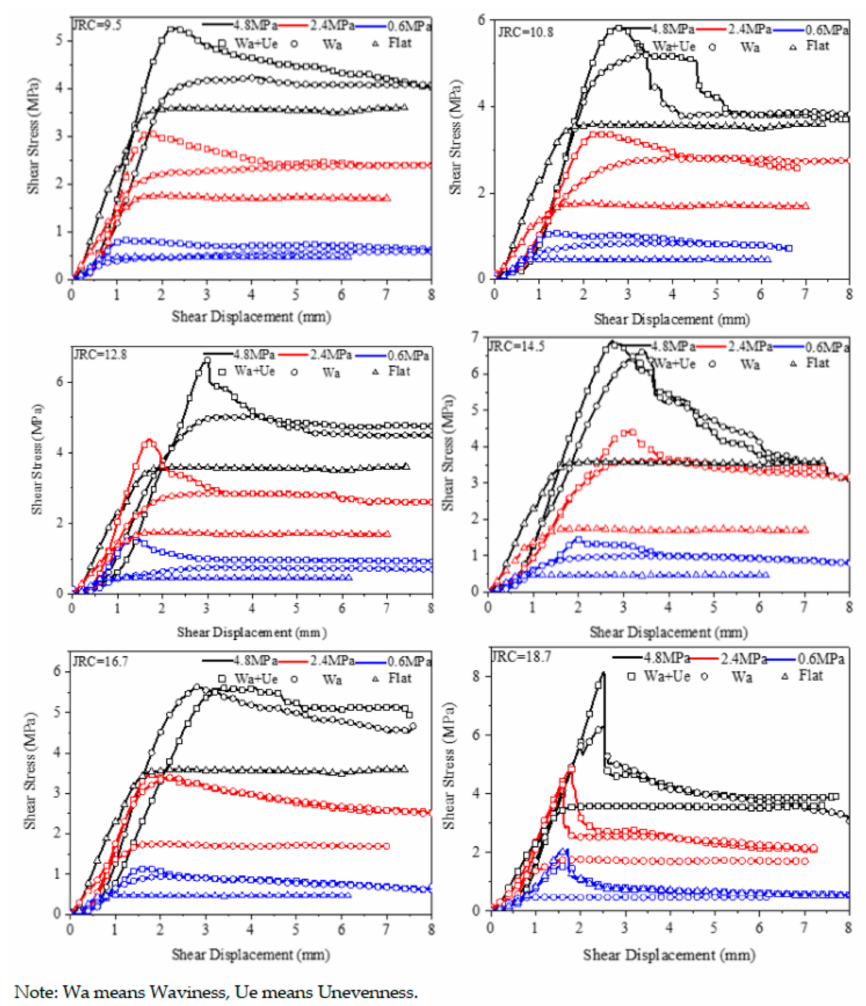
Figure 11. Shear stress–shear displacement